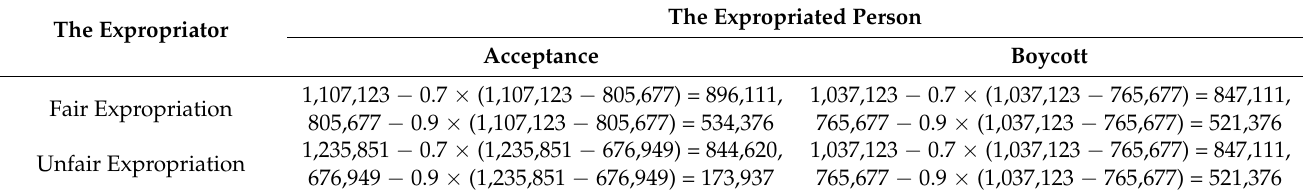
Table 10. The interactive fairness game matrix of urban housing expropriation compensation to the east of the Friendship